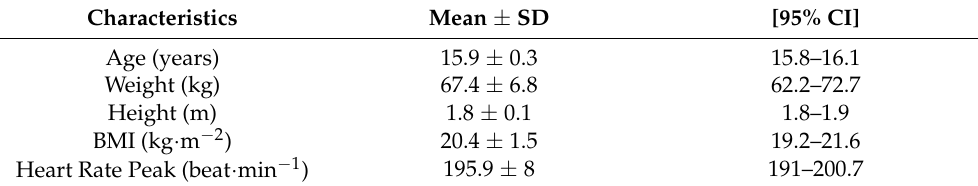
Table 1. Players’ descriptive characteristics. Values represent mean ± standard deviation (SD).